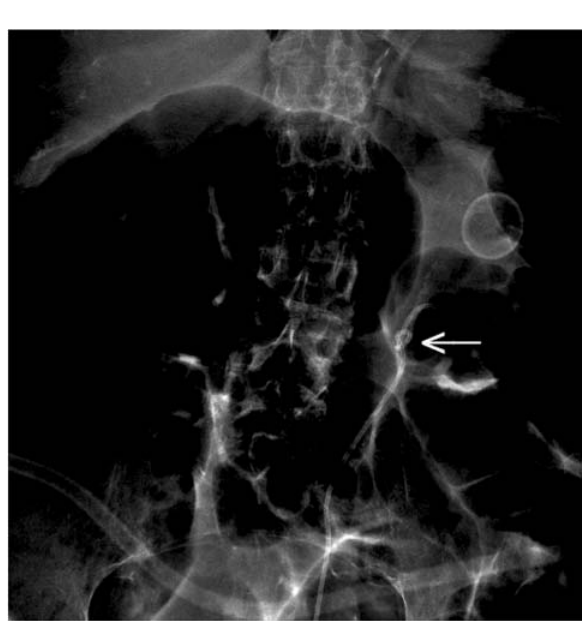
Figure 1 – Knot formation seen on abdominal X-ray